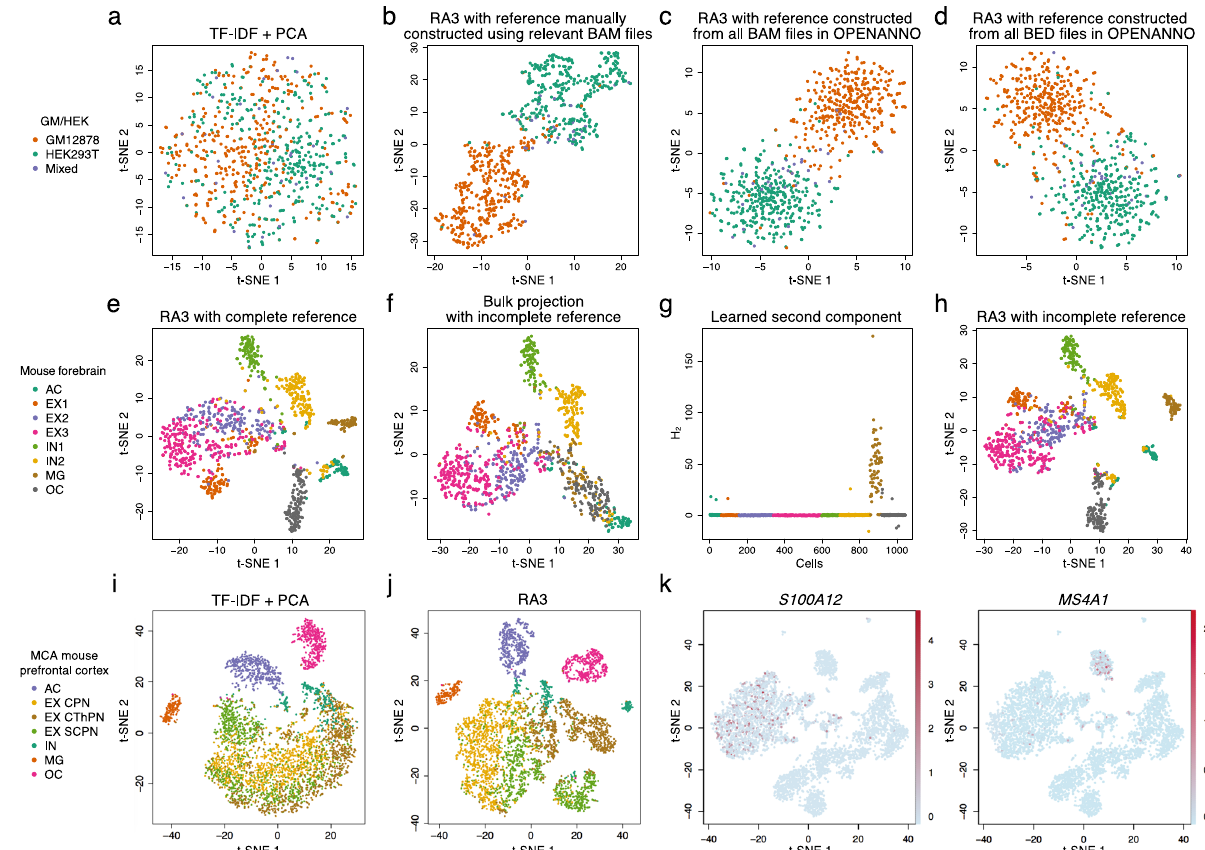
Fig. 2 RA3 incorporates reference data constructed from different sources. t-SNE visualizations of the cells in the GM/HEK dataset using latent features obtained from a TF-IDF + PCA, and from RA3 using reference data constructed from different samples, including b BAM fi les of bulk GM12878 and HEK293T DNase-seq samples, c BAM fi les of all the bulk samples in OPENANNO, and d BED fi les of all the bulk samples in OPENANNO. e We split